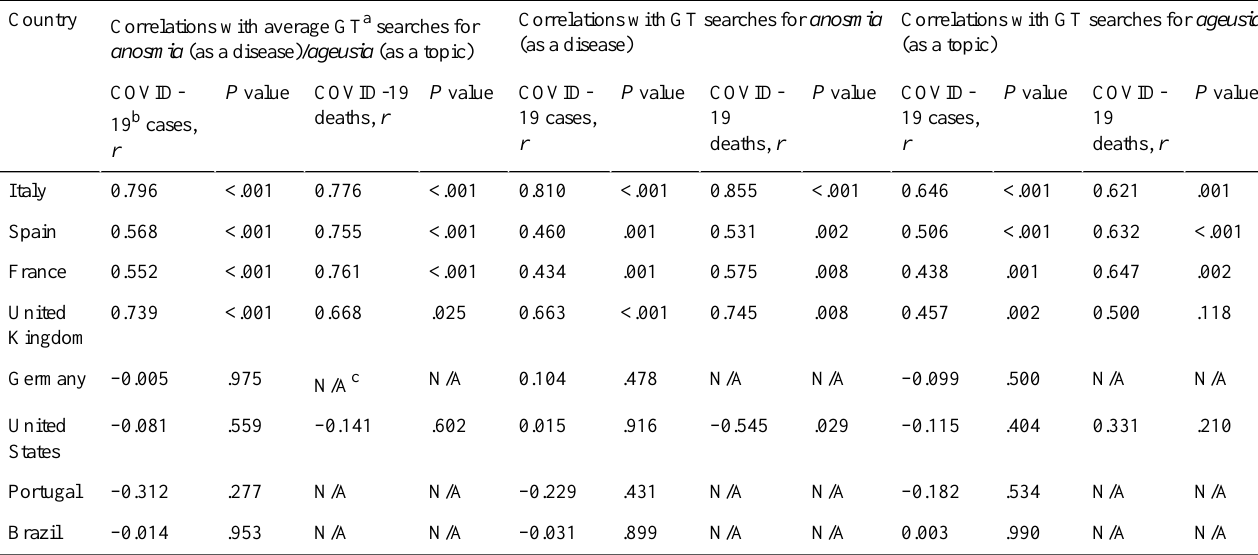
Correlations with GT searches for ageusia (as a